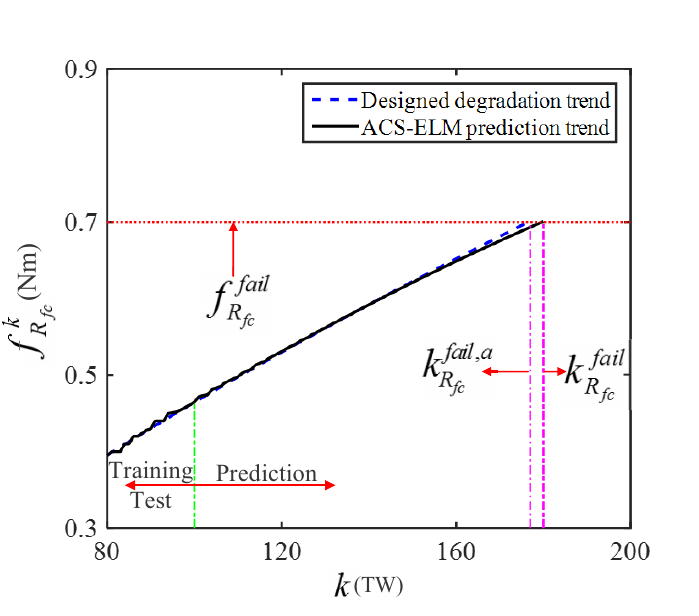
Figure 7. Estimation and prediction results of R fc